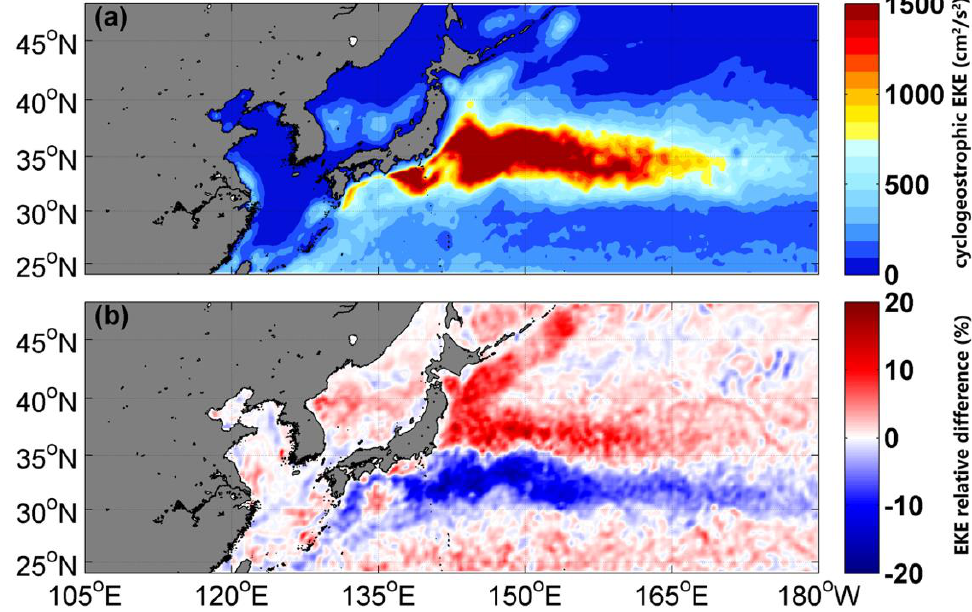
Figure 8. ( a ) Cyclogeostrophic average eddy kinetic energy and ( b ) relative difference between the multi-year (1998–2012) averages of the eddy kinetic energy of the cyclogeostrophic current and the geostrophic current in the Kuroshio Extension region.